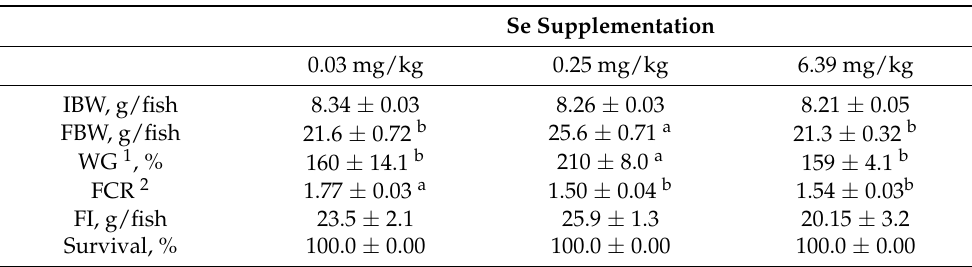
Table 1. Effects of dietary Se supplementation on growth performance and morphological parameters of yellow catfish after 12